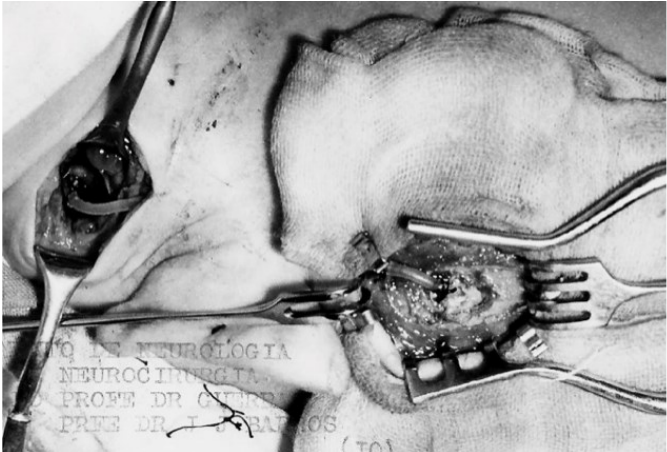
Figure 1 - Preoperative pneumoventriculography . Figure 2 - Surgical planning